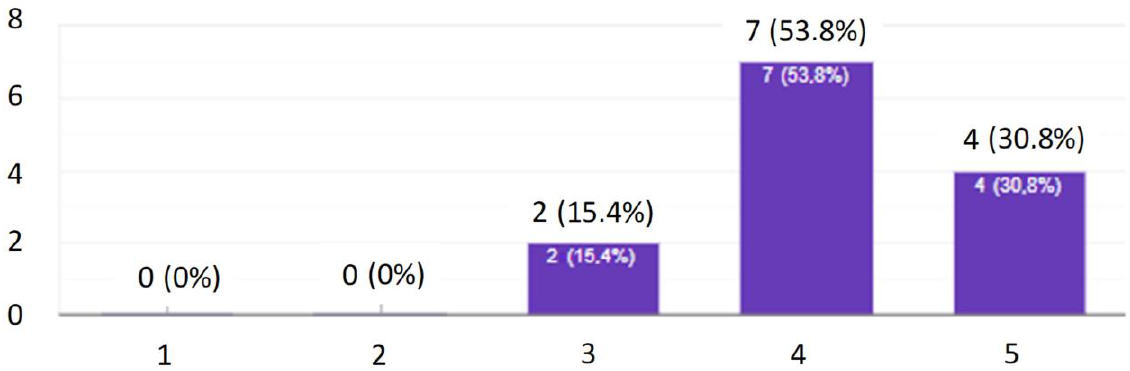
Figure 12. How do you rate the entire study on a scale of 1 to 5?